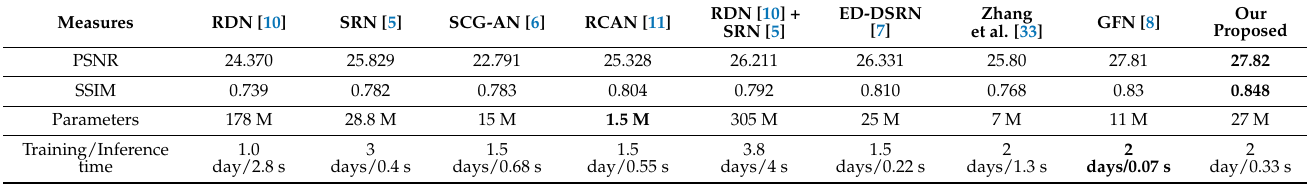
Table 2. The comparisons with SOTA methods of the quantitative performance on GOPRO dataset [2]. Best results are marked in bold.